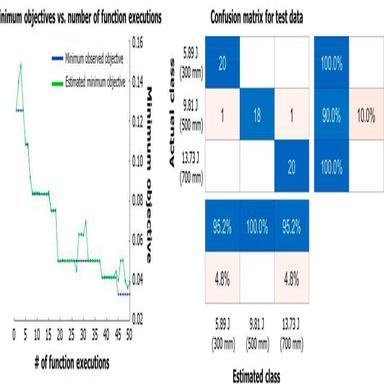
Performance evaluation results for the optimized CNN-based deep learning model for failure characterization.